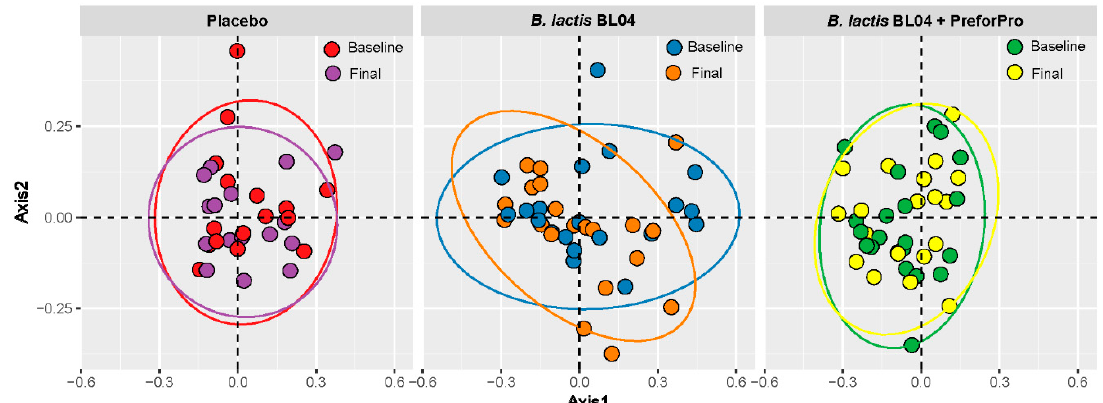
Figure 4. Principle Coordinates Analysis (PCoA) of Bray–Curtis distances at baseline and final visit for each treatment group.